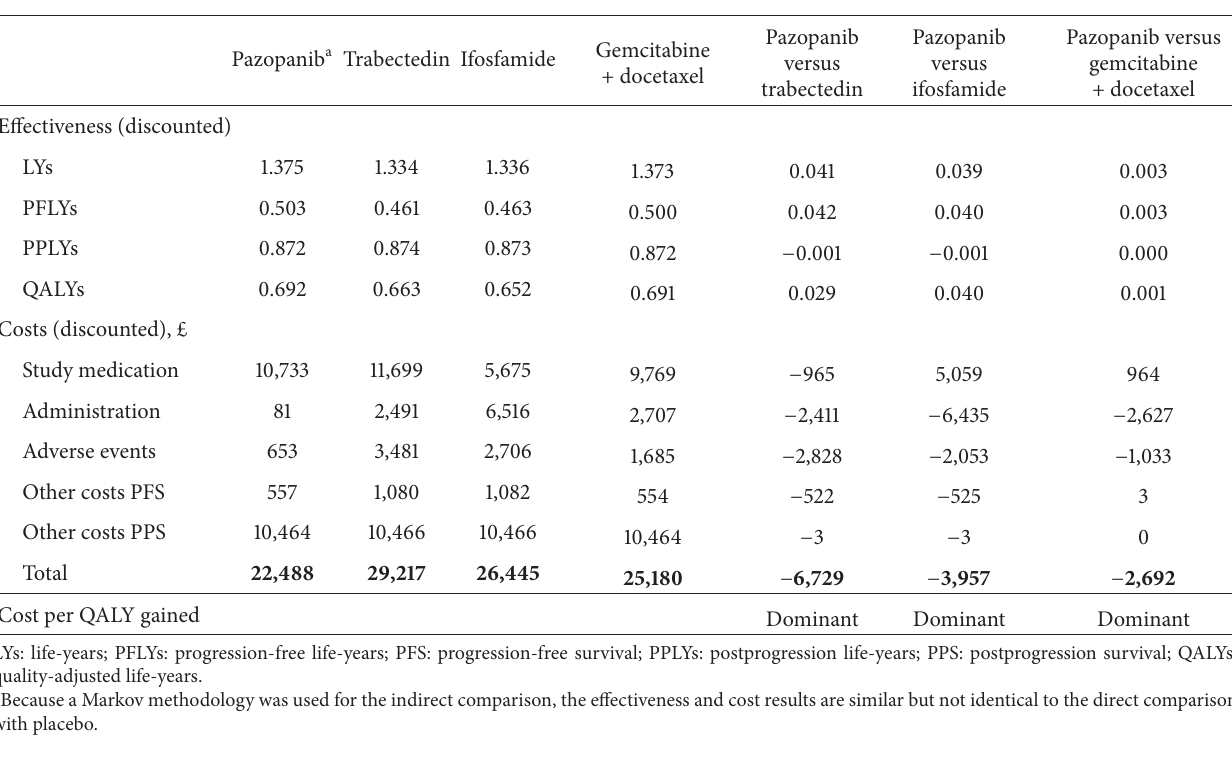
Table 6: Base-case results for pairwise indirect comparisons versus pazopanib (PPS-based analysis).